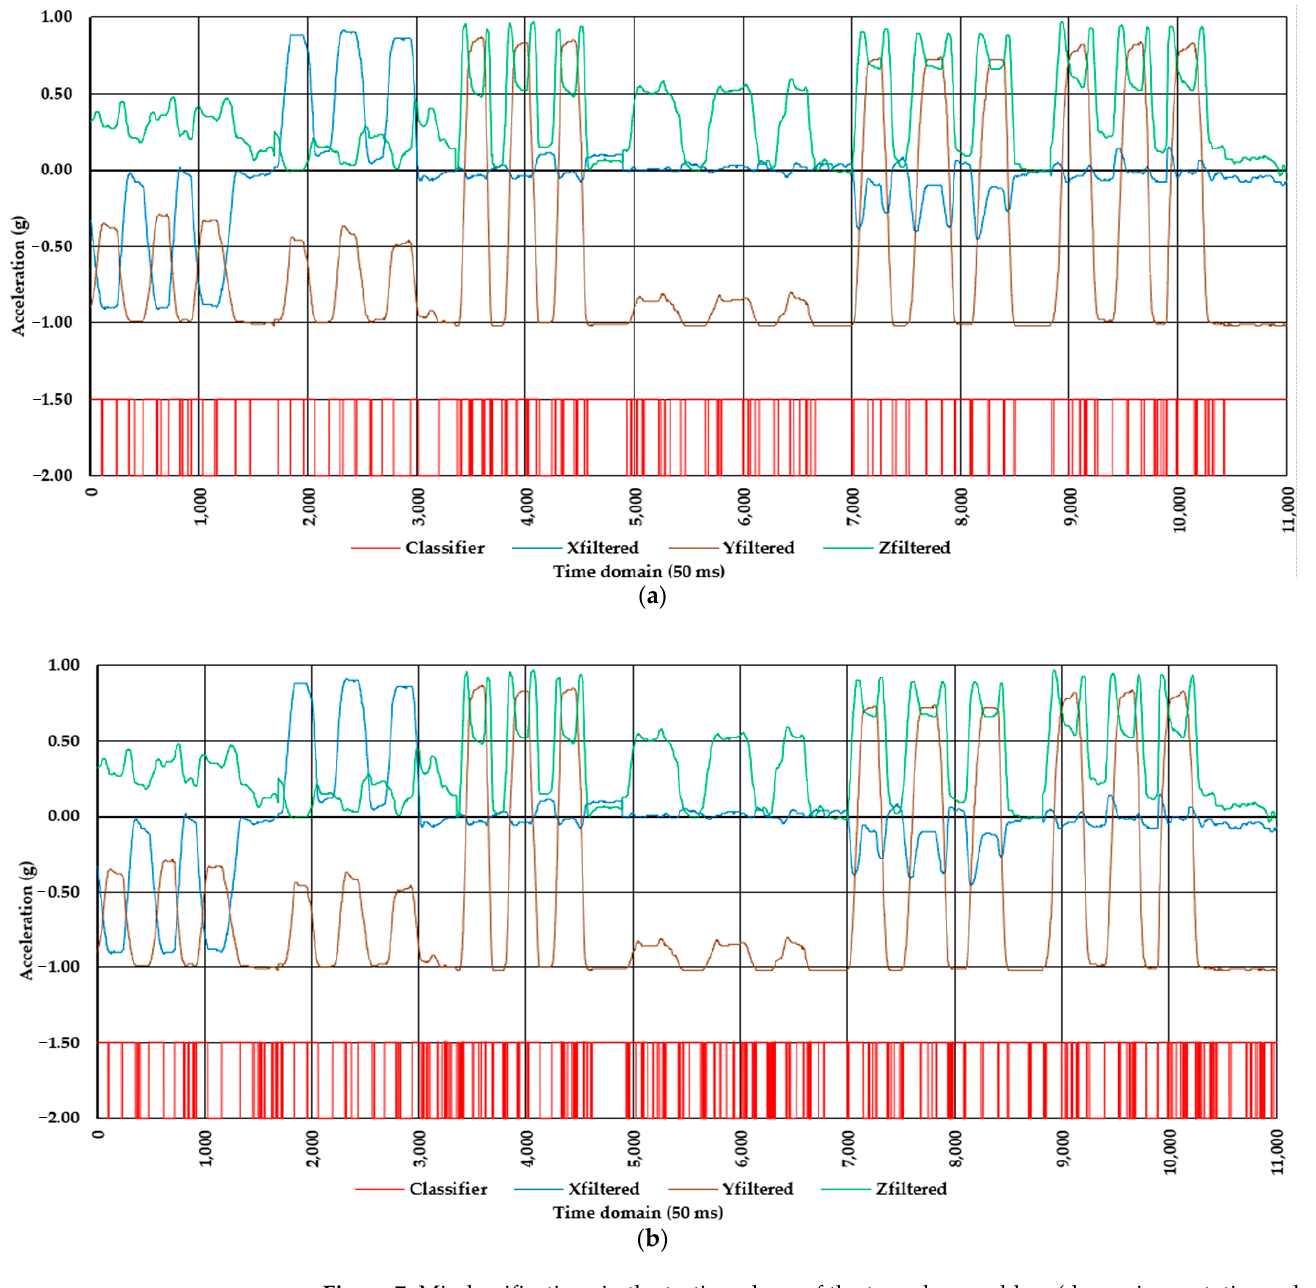
Figure 7. Misclassifications in the testing phase of the two-class problem (dynamic vs. static work of the back) by the two machine learning algorithms: ( a ) MLPBPNN ( α = 0.001) algorithm; ( b ) RF (number of trees = 10,000) algorithm. Legend: classifier—an arbitrary signal showing the correct (acceleration = − 1.5 g) and incorrect (acceleration = − 2.0 g) classifications; Xfiltered, Yfiltered, and Zfiltered are the values of the signals on the three axes after applying a median filter with a window size of 41.